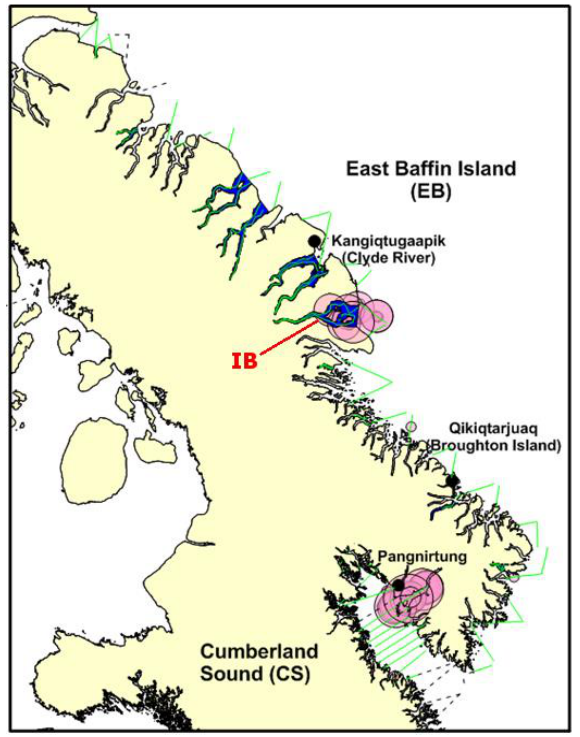
Figure 5. East Baffin and Cumberland Sound showing completed transects (green), un-completed planned transects (black dashed) and sightings of bowhead whales with symbol size proportional to group size (1 – 4). Surveyed fjord strata: blue; un-surveyed fjord strata: grey. IB: Isabella Bay (see Figure